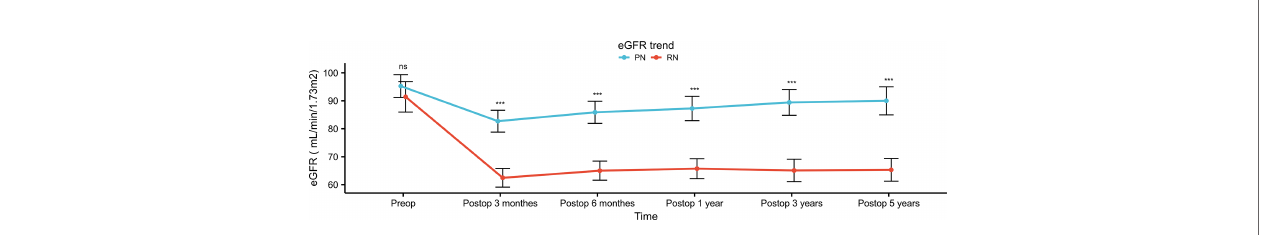
FIGURE 2 | Postoperative eGFR trend of patients in PN group and RN group after propensity score matching. eGFR, estimated glomerular fi ltration rate; PN, partial nephrectomy; RN, radical nephrectomy. "***" means p<0.001; "ns" means not statistically signi fi